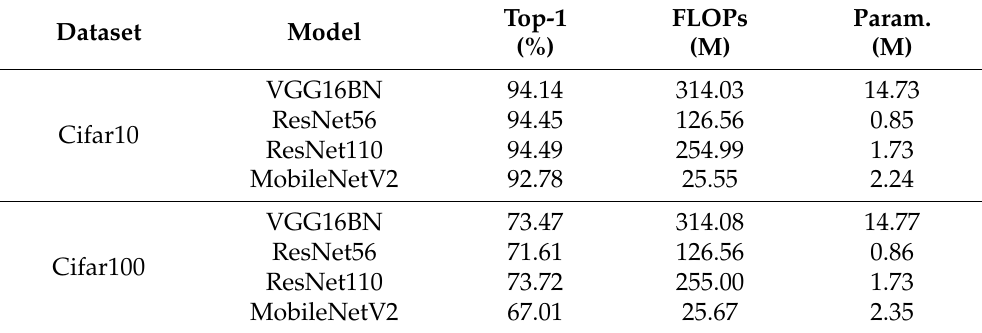
Table 1. Training results of base